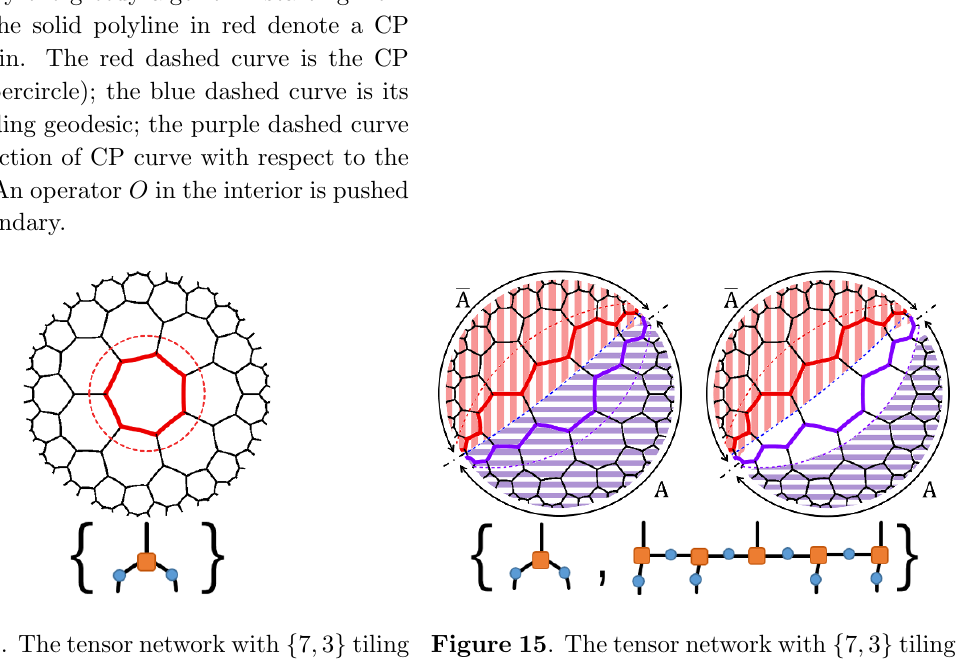
Figure 15 . The tensor network with f 7 ; 3 g tiling nh 1 i h 1 0 1 0 1 io and S c = ; 2 1 1 0 1 1